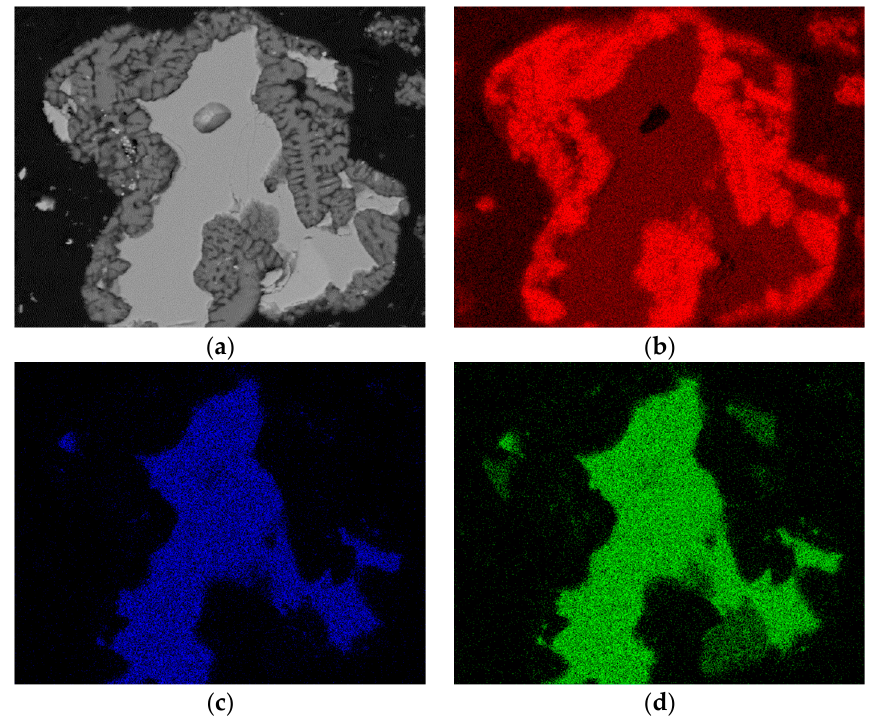
Figure 4. Punctual microanalysis by SEM-BSE-EDS in the leached residue of test P5. ( a ) Unreacted chalcopyrite particle, ( b ) unreacted galena particle, ( c ) unreacted Chalcopyrite particle, ( d ) unreacted Chalcopyrite particle.